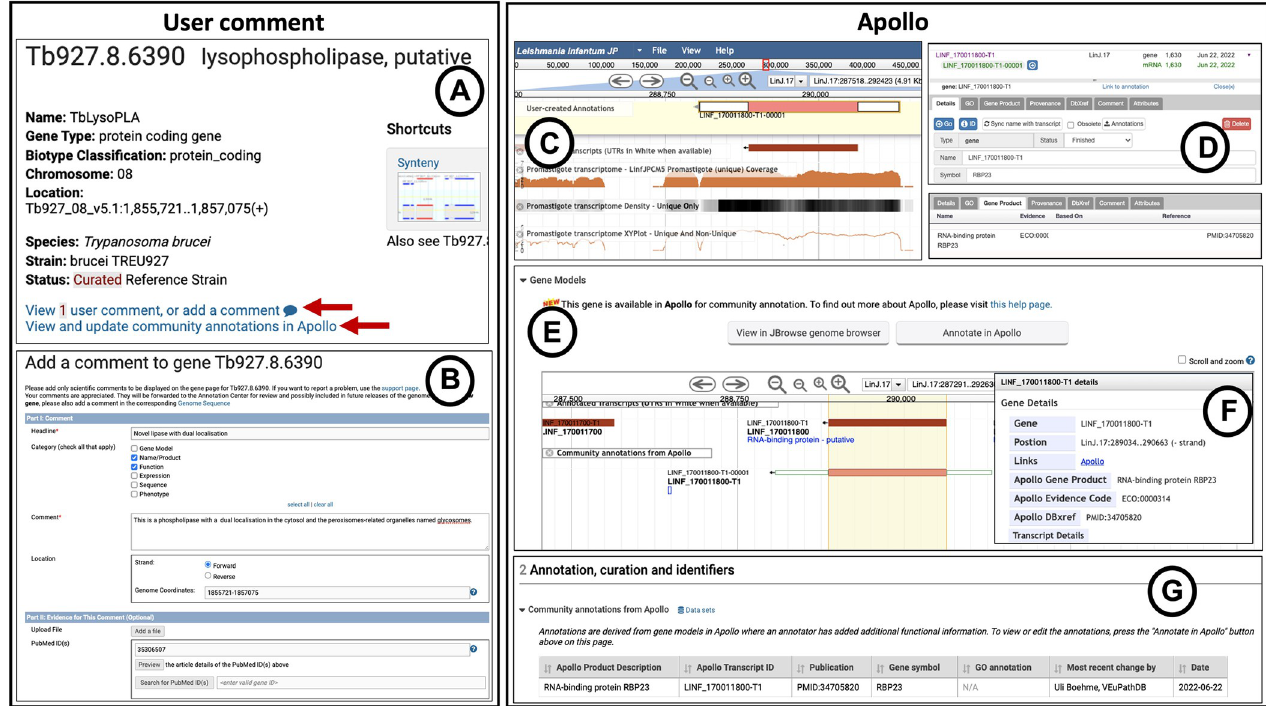
Fig 3. Community curation via User Comments and Apollo. (A) On the top of the gene record page are links to add User Comments and to access Apollo. (B) User Comment interface. (C) To annotate a gene in Apollo, the current gene model needs to be added to the User-created Annotations Area. (D) Interface in Apollo to add gene symbols, product descriptions, GO terms, database references and comments. Once the annotation is finalized, the status needs to be set as finished. (E) Finished annotations are shown on the gene page in the Gene models graphic in the track ‘Community annotations from Apollo’. (F) A popup shows Apollo product descriptions, evidence code and the publication that is associated with the gene. (G) Apollo product description, gene symbol and publication are shown in the Annotation, curation and identifiers section on the gene record page.